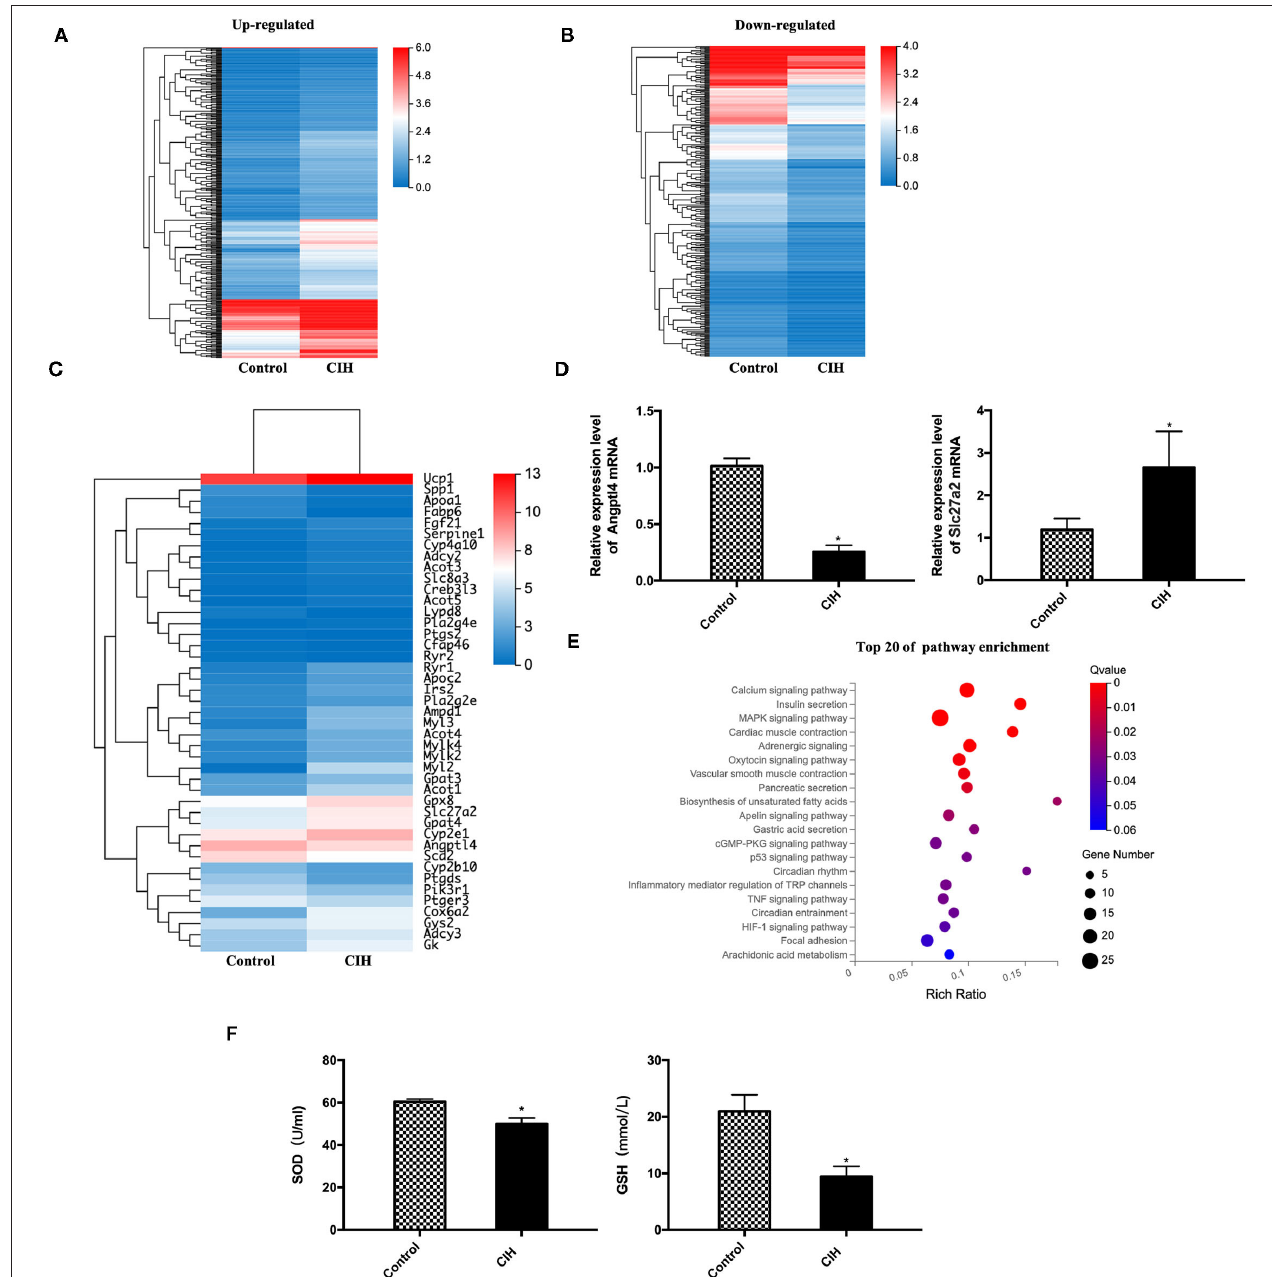
FIGURE 4 | Alteration of gene expression profiling and the pathway enrichment in ApoE − / − mouse BAT exposed to CIH. Male ApoE − / − mice exposed to normoxia or CIH grouped as control and CIH group. (A) A total of 387 up-regulated genes in BAT of CIH group compared with the control group. (B) A total of 337 down-regulated genes in BAT of CIH group compared with the control group. (C) A total of 43 lipolysis and lipid metabolism-associated mRNA of BAT showed different expression profiling between the CIH and control group. (D) Angptl4 and Slc27a2 mRNA expression in BAT. n = 6. Data were presented as mean ± SEM. * CIH versus control p < 0.05. (E) The top 20 of pathway enrichment based on KEGG was classified according to their functions related to metabolism, lipolysis, and signaling pathways. Calcium signaling pathway (with 20 genes), MAPK signaling pathway (with 25 genes), and adrenergic signaling pathway (with 16 genes) include the most gene number among the significantly enriched pathways. KEGG indicates Kyoto Encyclopedia of Genes and Genomes. n = 3. (F) SOD levels and GSH levels in mouse serum. n = 6. Data were presented as mean ± SEM. * CIH vs. control p < 0.05. SOD indicates superoxide dismutase. GSH indicates glutathione.